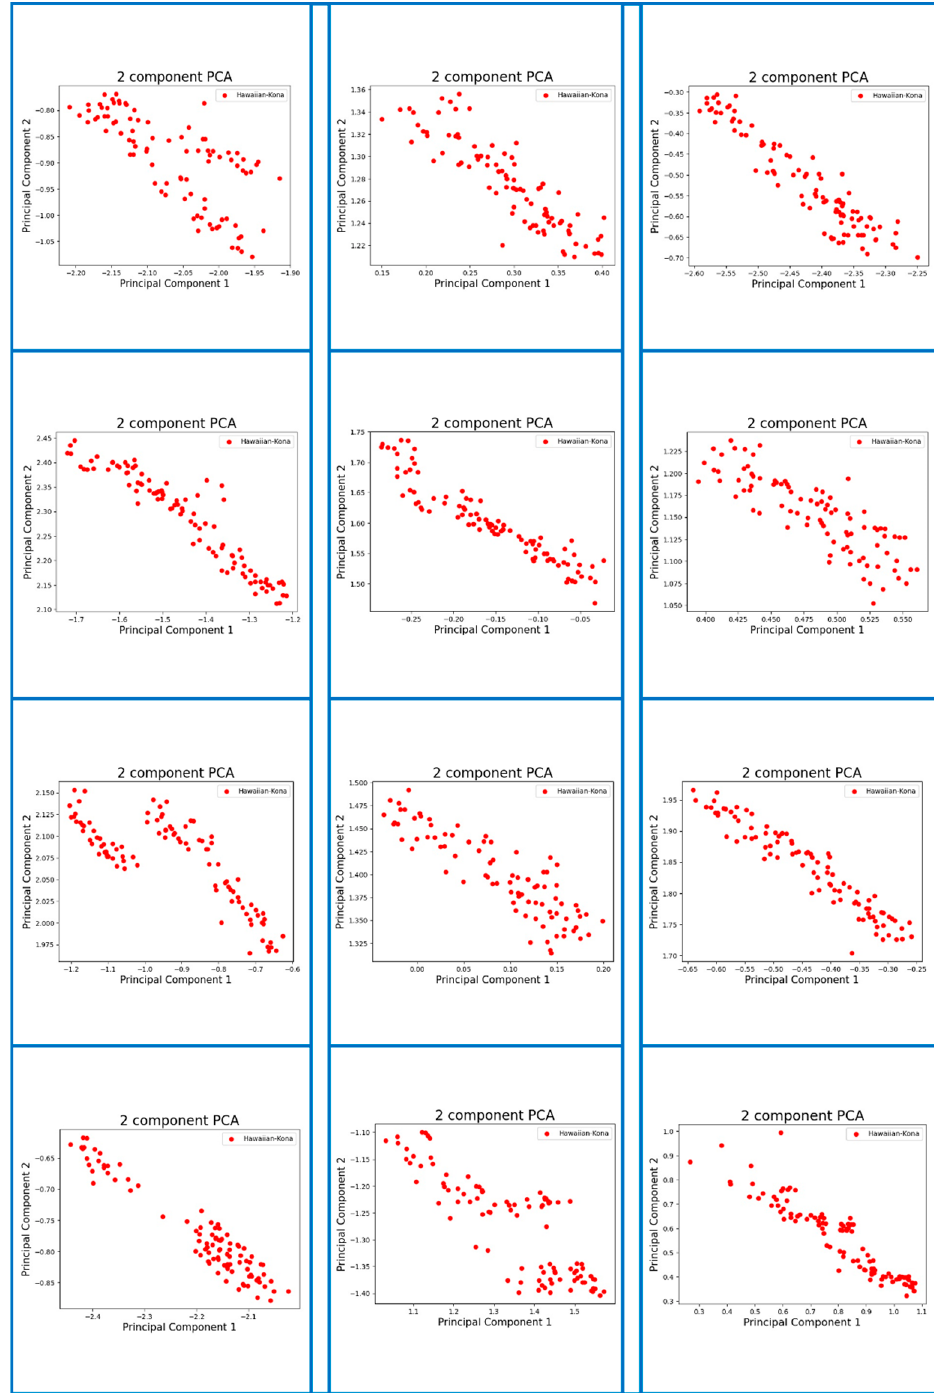
Figure A4. Sample digital fingerprints of coffee aromas originating from Kona, Hawaii.